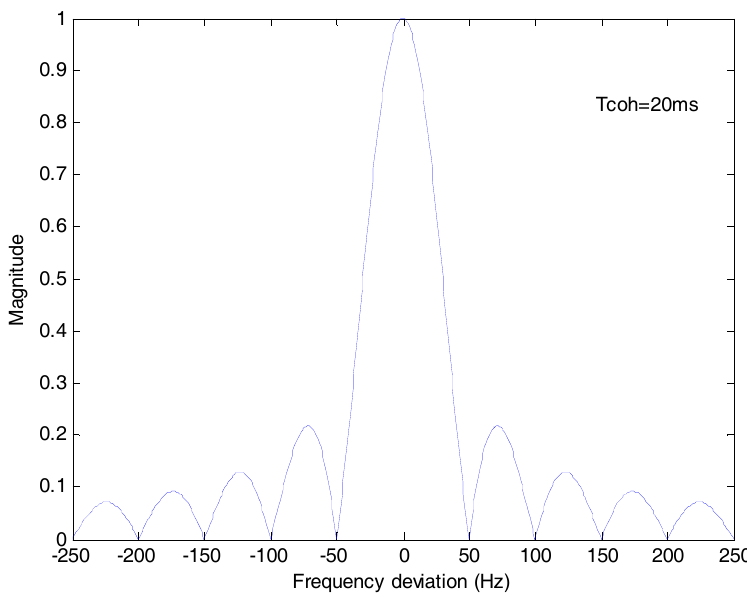
Figure 3. The amplitude attenuation of ML bit synchronization method due to frequency deviation. The coherent integration time T coh is 20 ms.